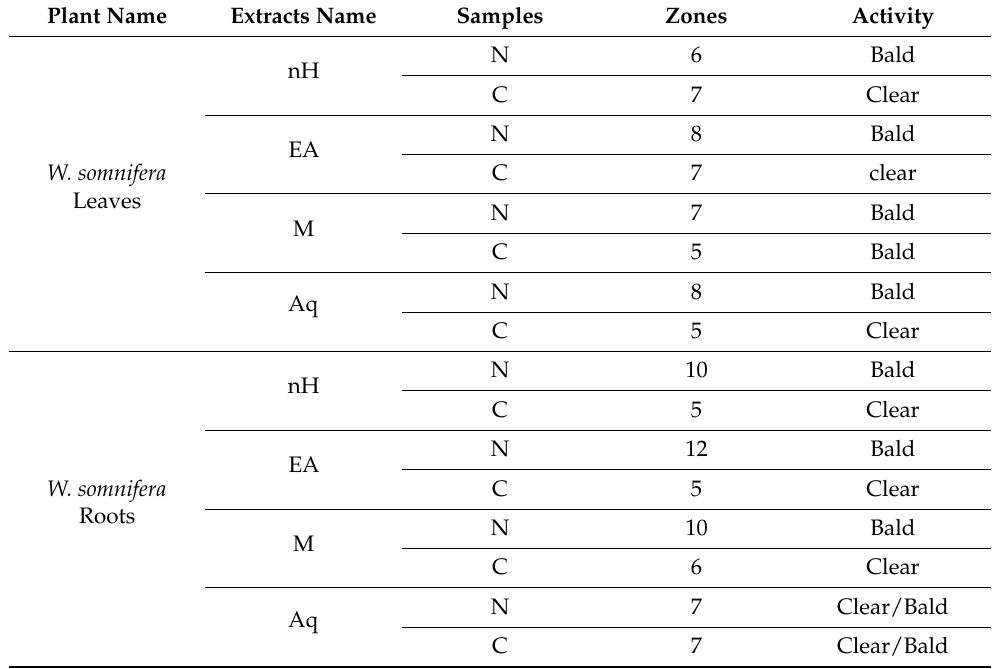
Table 5. Protein kinase inhibition potential of W. somnifera crude extracts and ZnONPs.